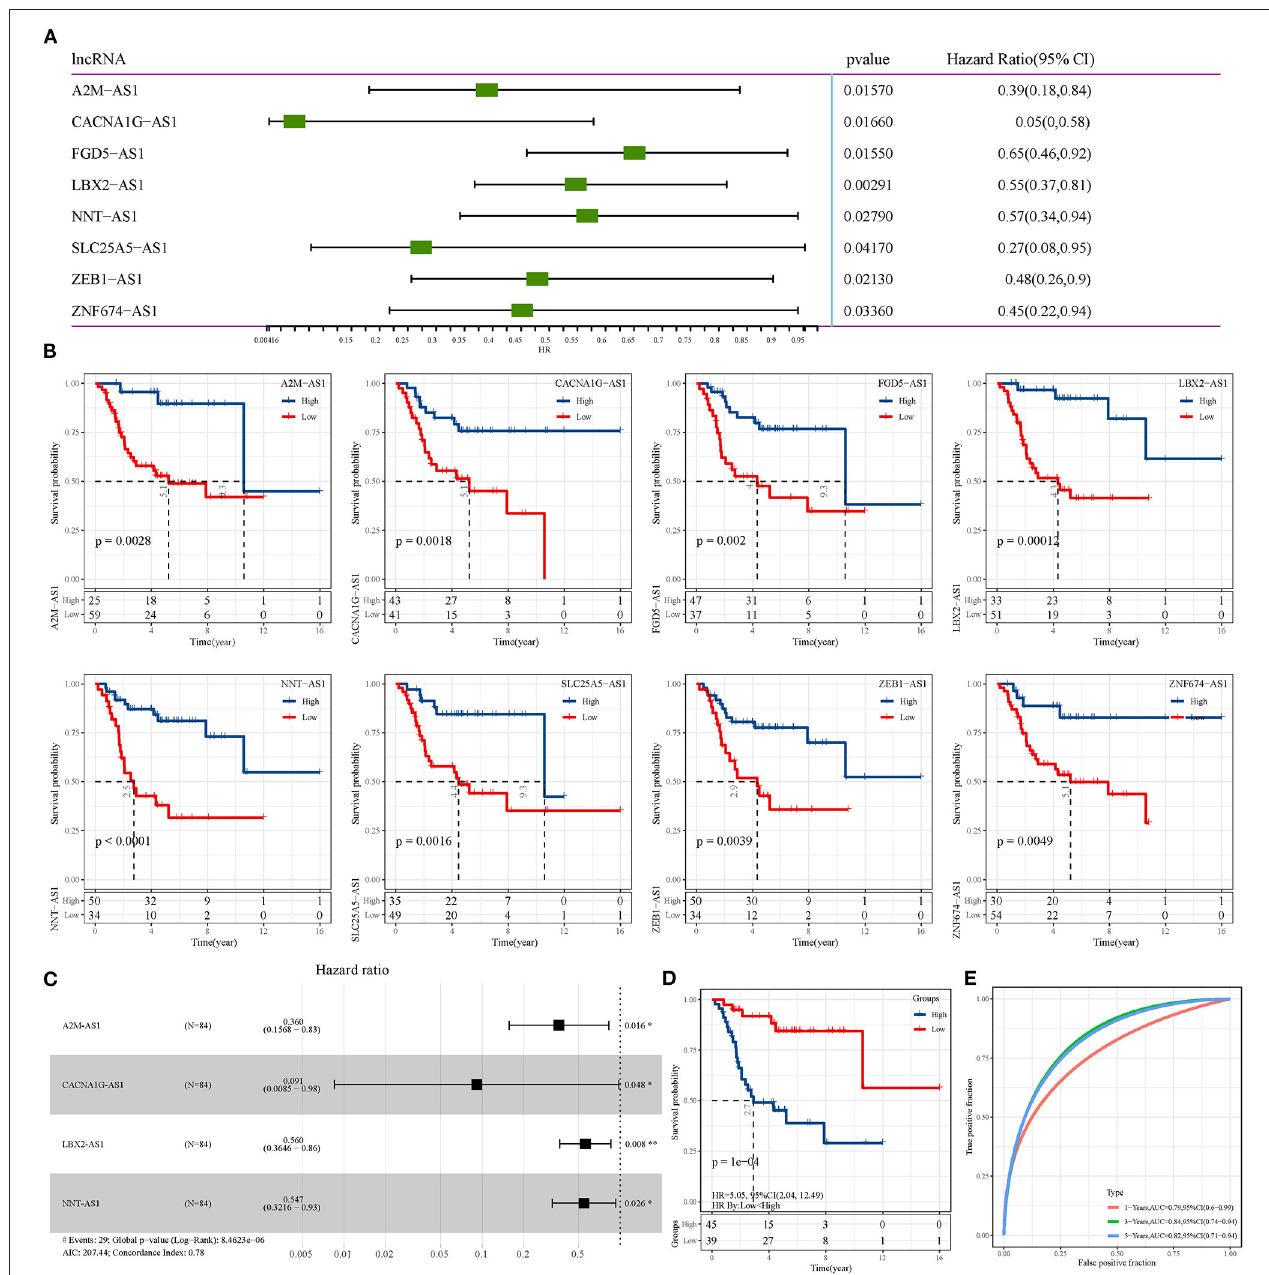
FIGURE 4 | Construction of osteosarcoma prognostic signature based on epi-lncRNAs. (A) Univariate Cox regression analysis of 8 epi-lncRNAs significantly correlated with OS of osteosarcoma. (B) The OS of osteosarcoma patients was evaluated according to the expression of each of the 8 epi-lncRNAs. (C) Forest map of 4 epi-lncRNAs by multivariate Cox regression analysis. (D) The survival curve of patients with different risks assessed by the 4-epi-lncRNA signature. (E) The ROC curve shows the area under curve (AUC) of the 1-, 3-, and 5-year OS calculated by the 4-epi-lncRNA